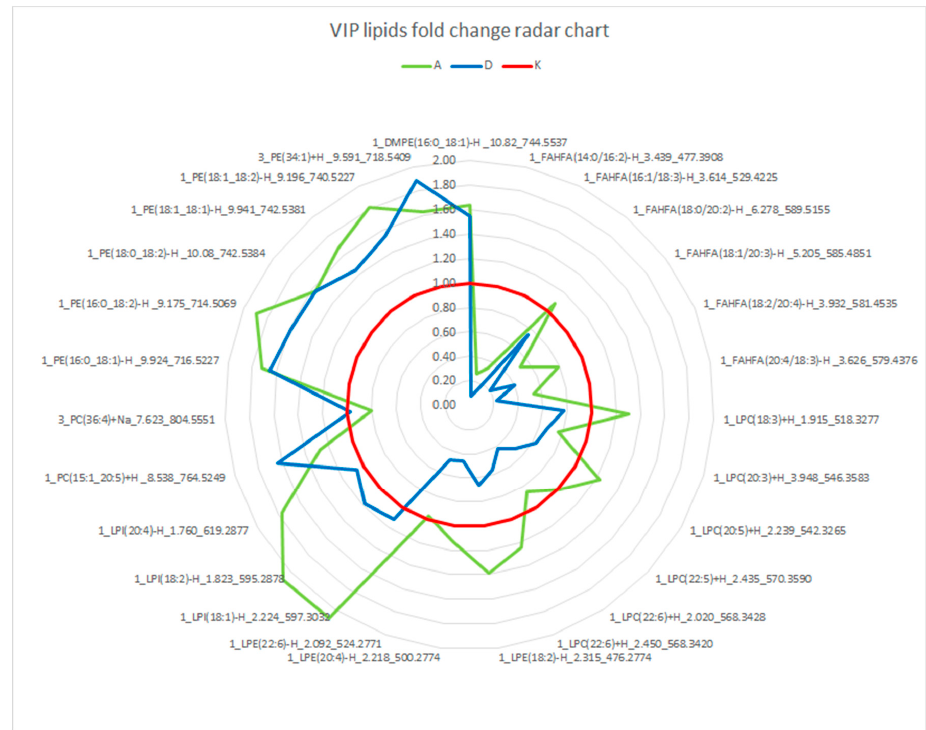
Figure 3. Radar chart showing trends of significant polar lipids among the groups by plotting the median fold change over the control group. FAHFA—fatty acyl of hydroxyfatty acid; LPC—lysophosphocholine; LPE—lysophosphoethanolamine; LPI—lysophosphoinositol; PC—phosphocholine; PE—phosphoethanolamine; DMPE—dimethylphosphoethanolamine.